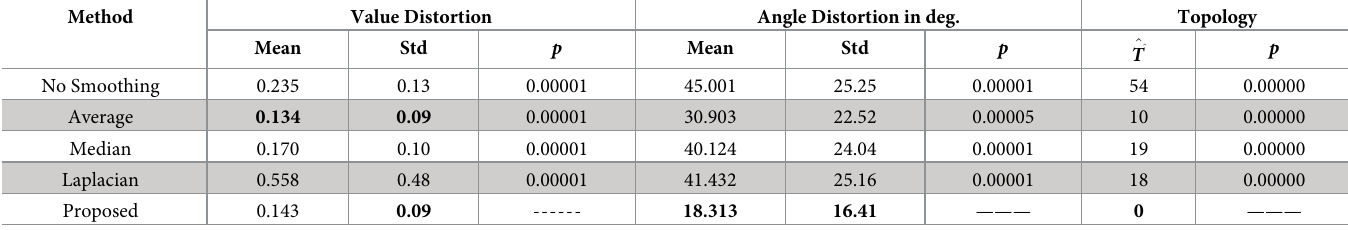
Table 2. Comparison of different smoothing methods based on three metrics: value deviation, angle distortion, and number of flipped triangles with a small amount of noise (PSNR = 10). Method